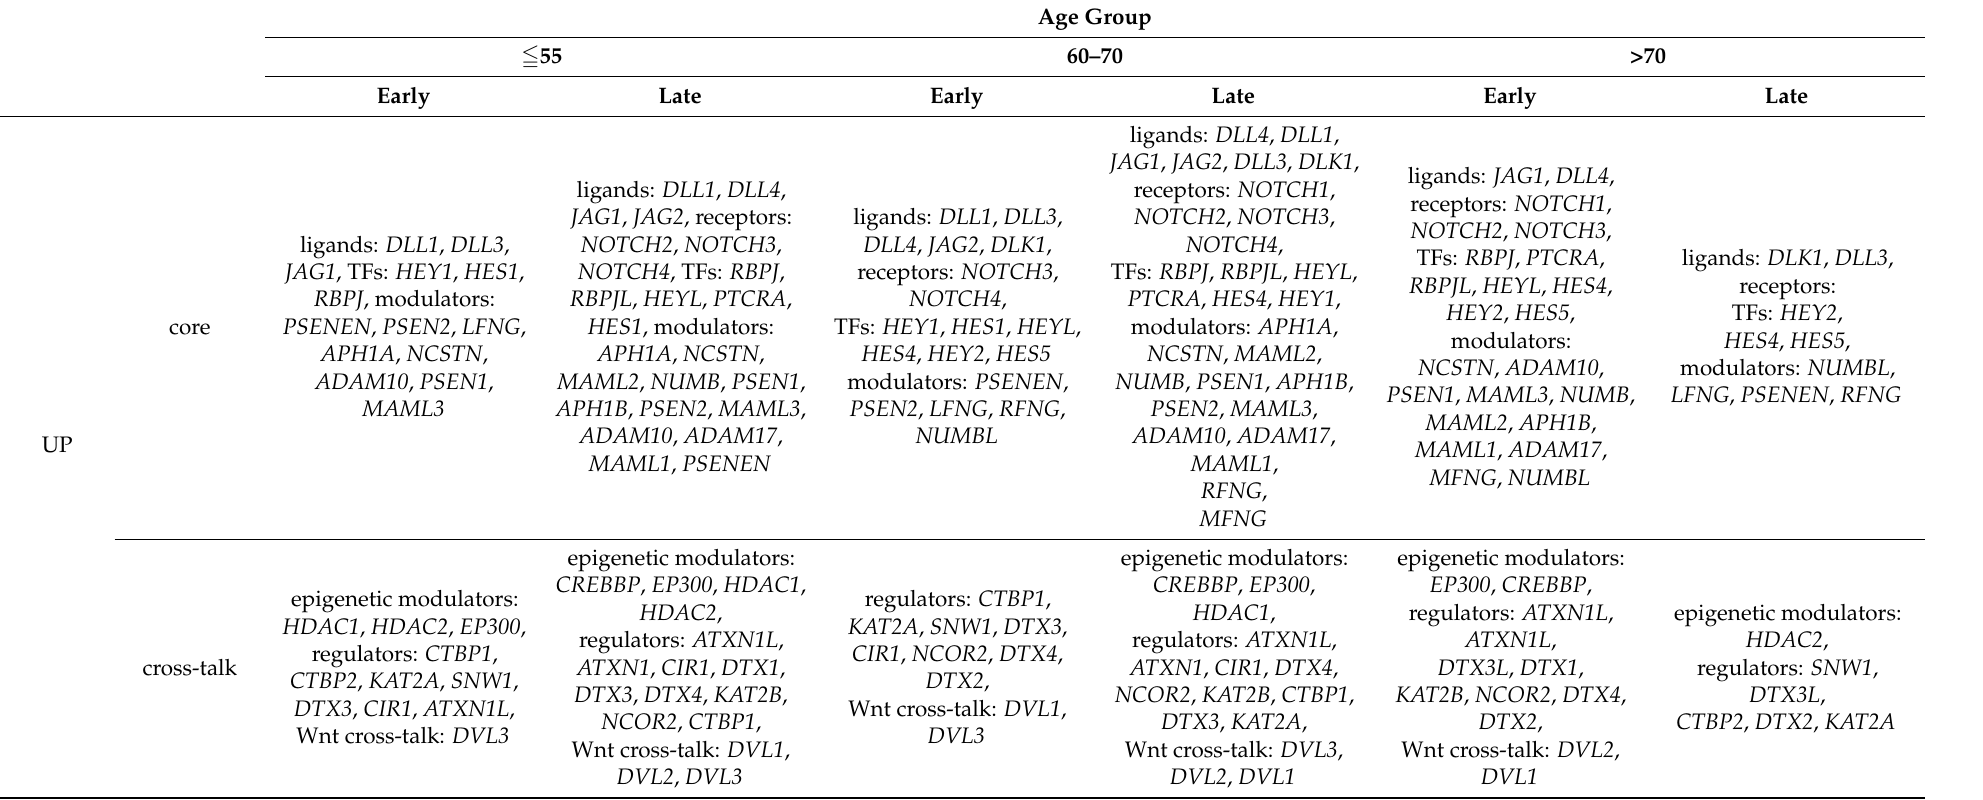
Table 1. A detailed comparison of the Notch expression between tumor stages according to the age of PC